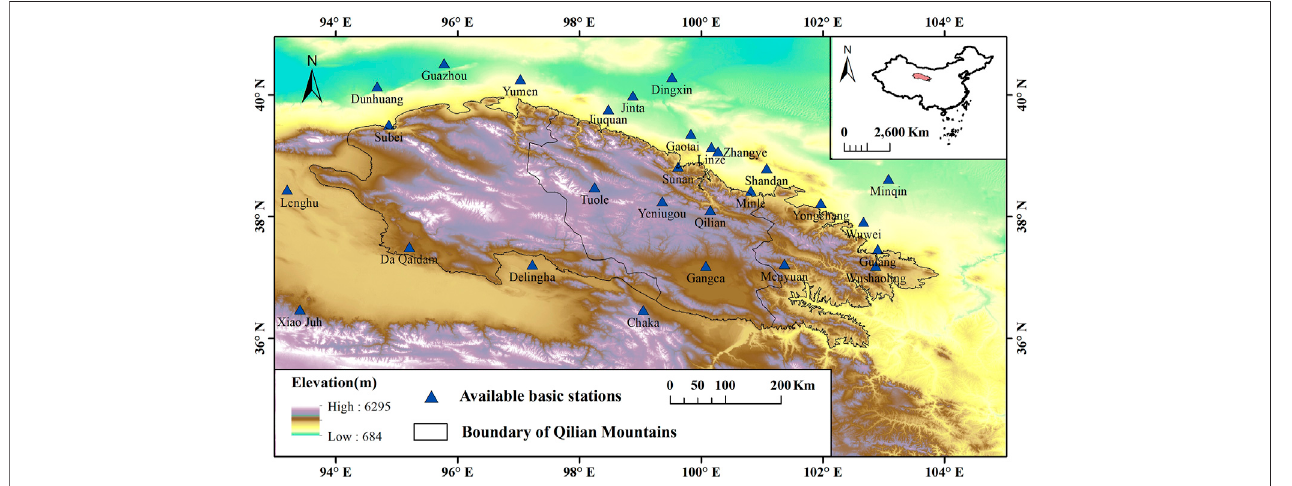
FIGURE 1 | Map of the study area and location of 28 weather stations in the Qilian Mountains and its surroundings.